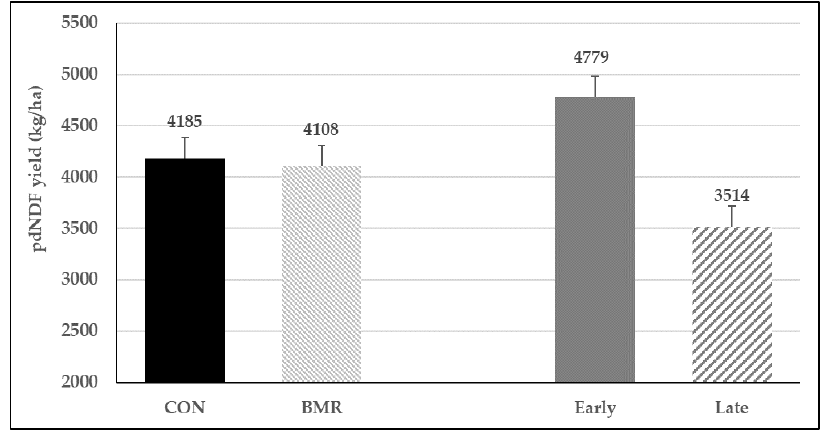
Figure 2. In vitro NDF digestibility (IVNDFD) of pearl millet genotypes planted at two different dates (May 9th and May 18th) and harvested three times during 2018 (Trial 1). Gen ( p < 0.01), plant- ing date ( p = 0.60), and Gen × planting date ( p = 0.28); vertical bars indicate standard errors of the mean.